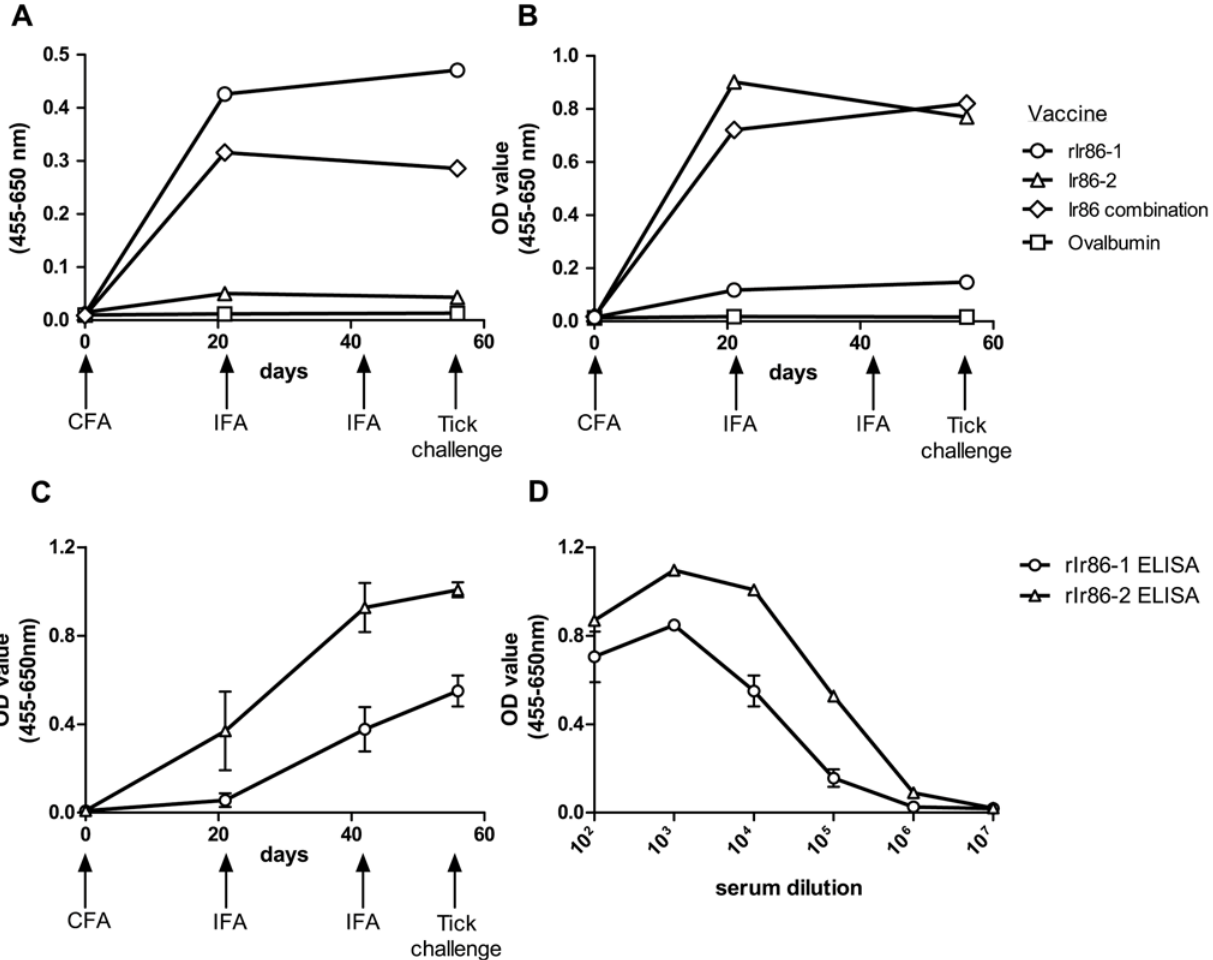
Fig 2. Specificity and IgG response against rIr86-1 and rIr86-2 in experiment A (pilot experiment) and B (confirmatory experiment). IgG in serum (1:10,000) was assessed with ELISA using 1 μ g/mL of rIr86-1 and rIr86-2 on anti-V5 coated plates. A and B . IgG response in serum from animals in experiment A vaccinated with rIr86-1 (circle), rIr86-2 (triangle), rIr86-combination (diamond) or ovalbumin (square) (n = 1 for each vaccine) reacting to rIr86-1 (A) or rIr86-2 (B). C. Mean IgG response in serum (1:10,000) from three animals vaccinated against rIr86-combination in experiment B measuring IgG response to rIr86-1 (circle) or rIr86-2 (triangle). D. Mean IgG titer in serum from three animals vaccinated against rIr86-combination in experiment B, diluted 1:10 2 to 1:10 7 on ELISA coated with rIr86-1 (circle) or rIr86-2 (triangle). Error bars represent mean ± SEM.